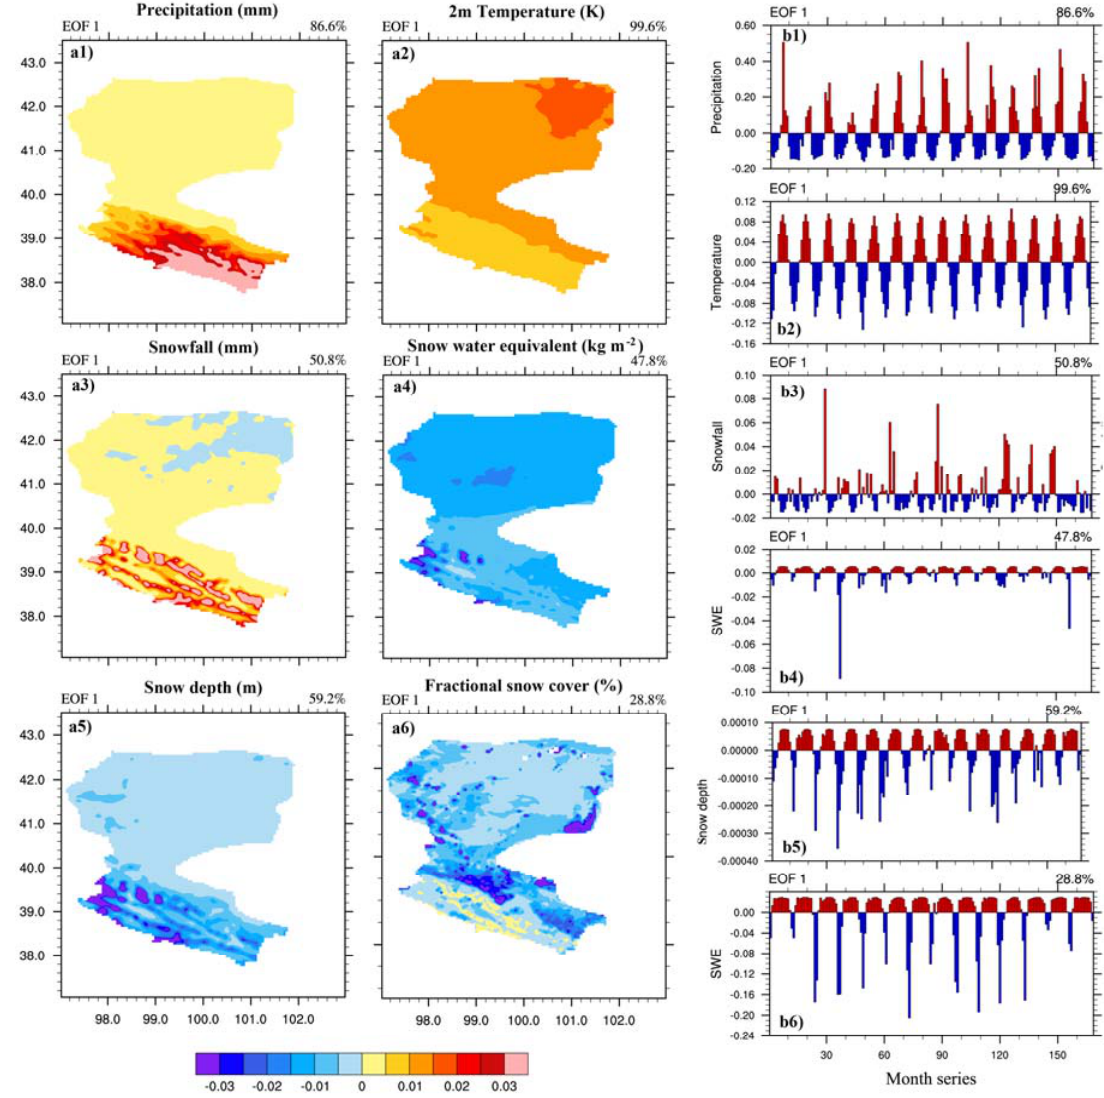
Figure 9. The first Empirical Orthogonal Function (EOF) spatial patterns ( a1 – a6 ) and the first principal component (PC) time series ( b1 – b6 ) from 2000 to 2013 for ( a1 , b1 ) precipitation; ( a2 , b2 ) 2m temperature; ( a3 , b3 ) snowfall; ( a4 , b4 ) SWE; ( a5 , b5 ) snow depth; ( a6 , b6 ) FSC. Table 1. Probabilities and trends in precipitation, snowfall, SWE, snow depth and FSC at different altitude